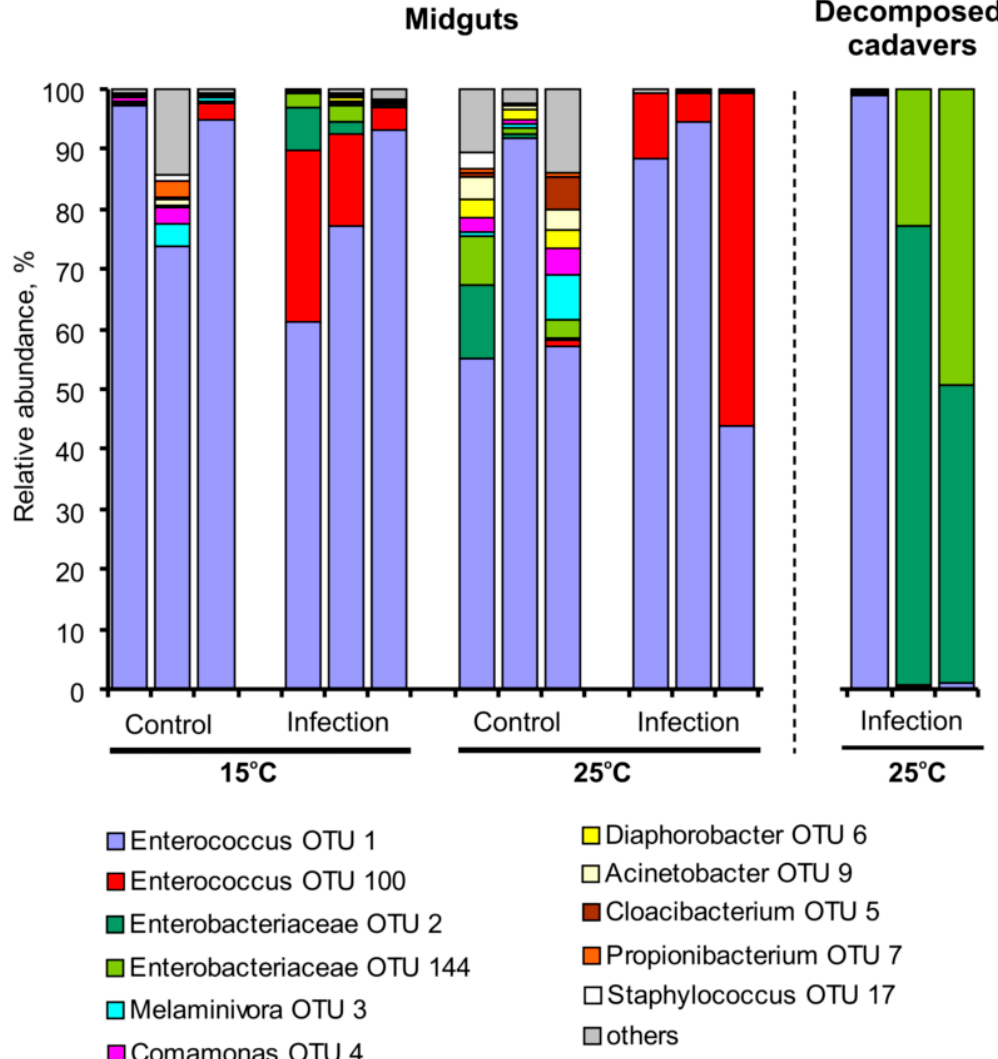
Figure 4. Bacterial communities (16S rRNA) in the midguts of wax moth larvae during the development of C. militaris infection at di ff erent temperatures and the communities in the cadavers that decomposed after the infection. Midgut communities were analyzed at 96 h after injection with a dose of 2500 conidia per larva. Decomposed cadavers were analyzed at 6–7 days post injection. Each treatment represents 3 replicates.